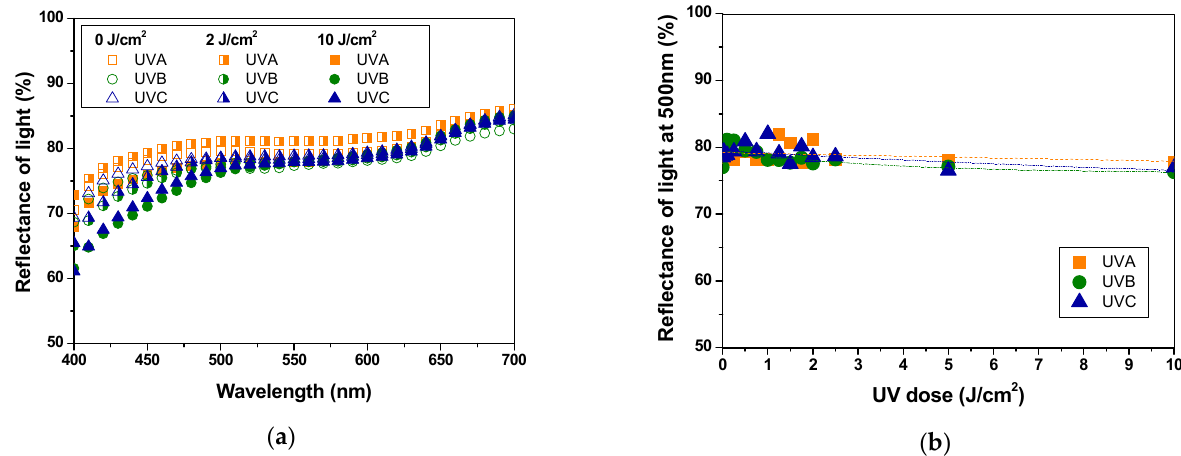
Figure 2. Basic characteristics of paper samples (non-refined paper) without the PAN–PDA dopant irradiated with UV light. ( a ) reflectance spectra measured immediately after UV irradiation (UV doses are given in the graph). ( b ) reflectance (at 500 nm) dependencies versus absorbed dose of UVA, UVB, and UVC light.